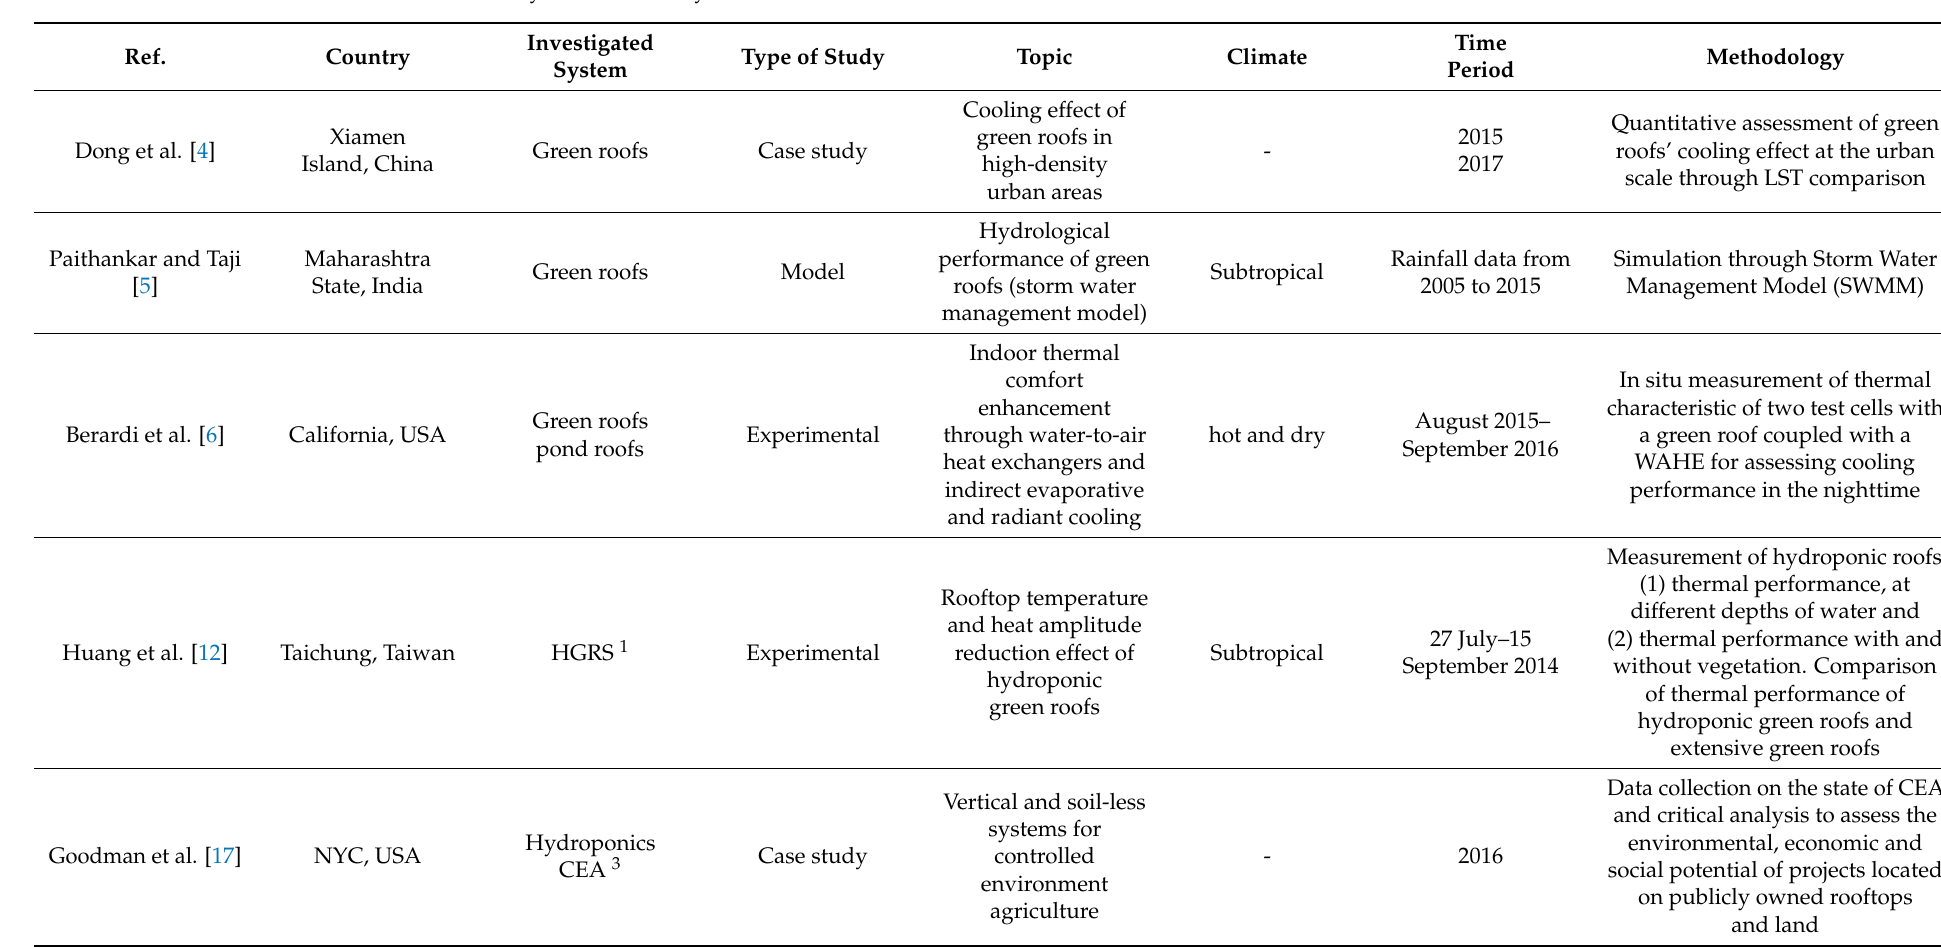
Table 1. Summary scheme of analyzed